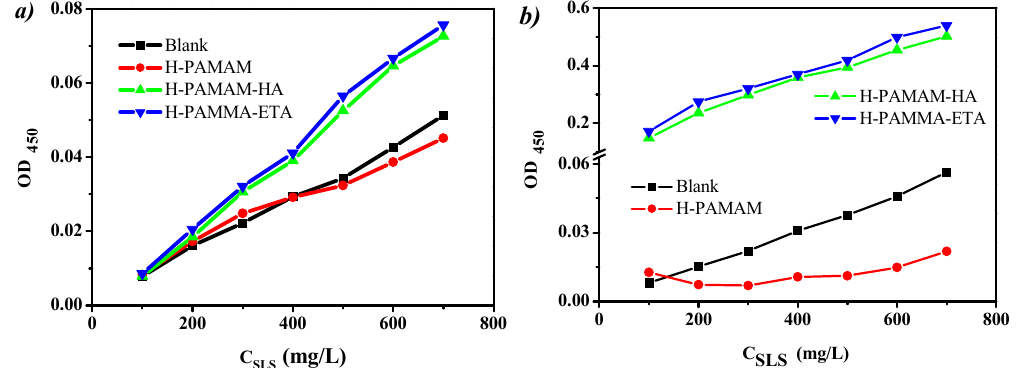
Figure 6. The turbidity measurements of the demulsifier–sodium lauryl sulfonate (SLS) mixtures using an optical density of 450 nm for ( a ) data obtained immediately with/without demulsifiers and ( b ) data recorded after letting the mixtures settle for 24 h.